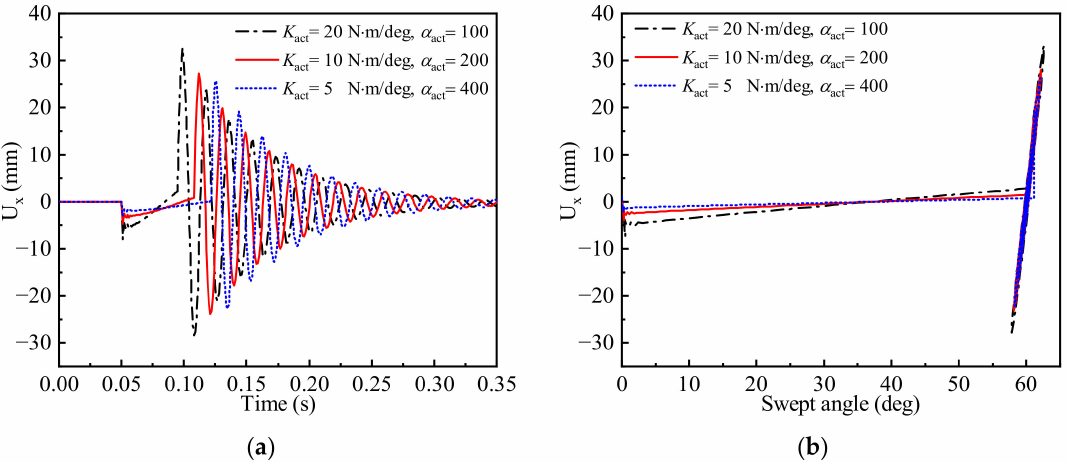
Figure 15. Transient responses of the chord-wise displacement at the wing tip. ( a ) Displacement vs. time. ( b ) Displacement vs. sweep angle.